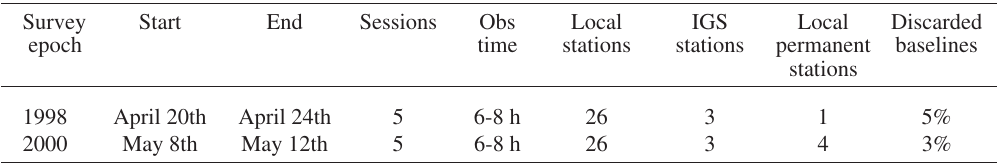
Table I. General features of the 1998 and 2000 Survey